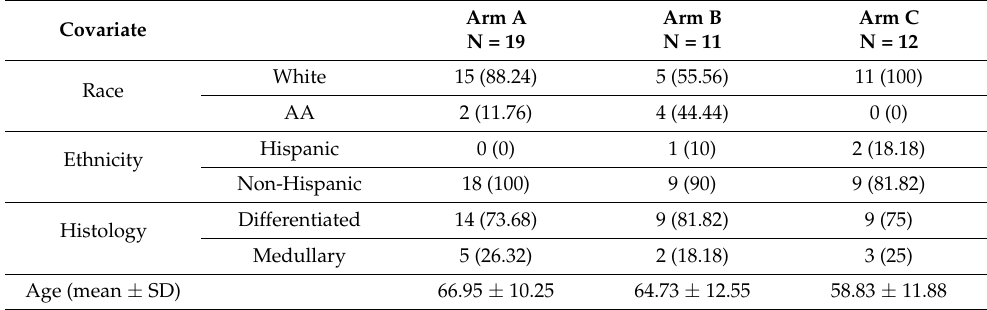
Table 1. Patient demographics, tumor characteristics, and distribution by treatment